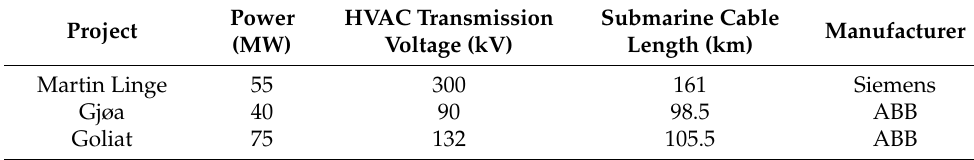
Table 2. Some of HVAC technology projects for offshore platforms power from Norwegian shore [10–12]. Power HVAC Transmission Submarine Cable Project Manufacturer (MW) Voltage (kV) Length (km) Martin Linge